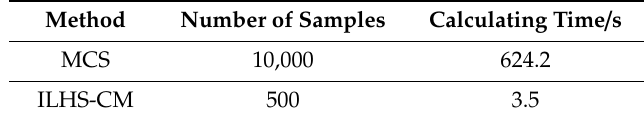
Table 5. Comparison of calculation time between di ff erent algorithms.